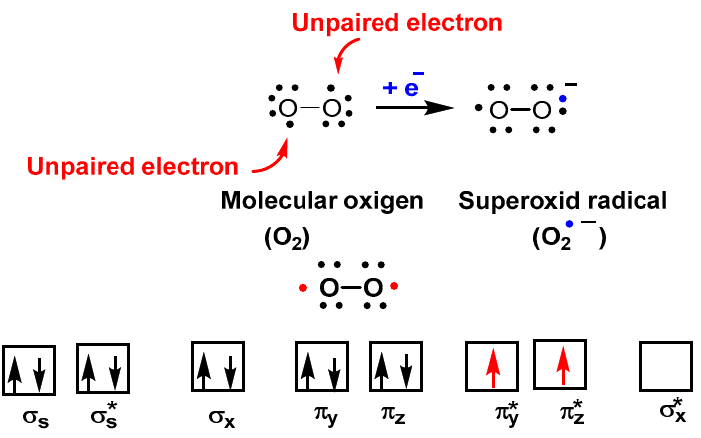
Figure 2. Molecular orbital diagram of O 2 showing its biradical nature.